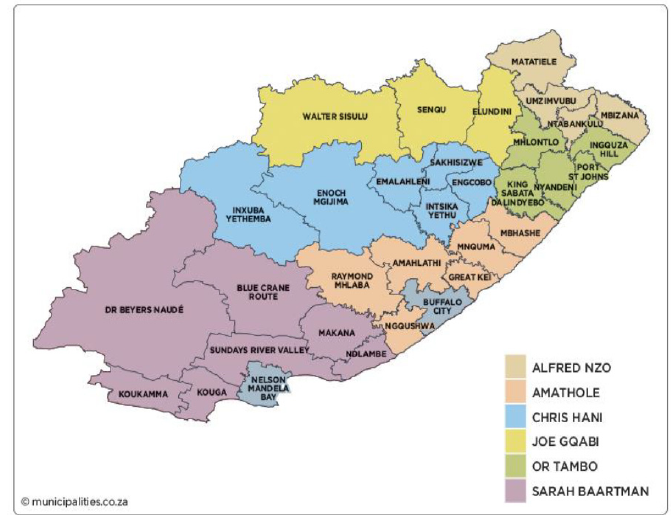
Figure 1. Map showing the study location.